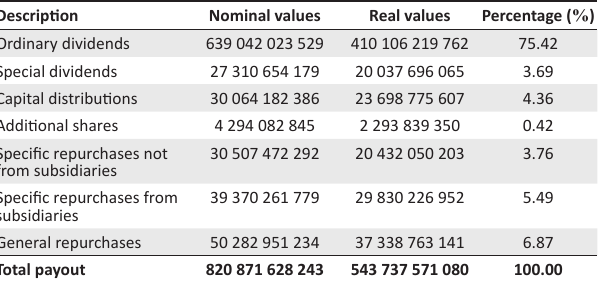
TABLE 1: Values of different payout methods for the period